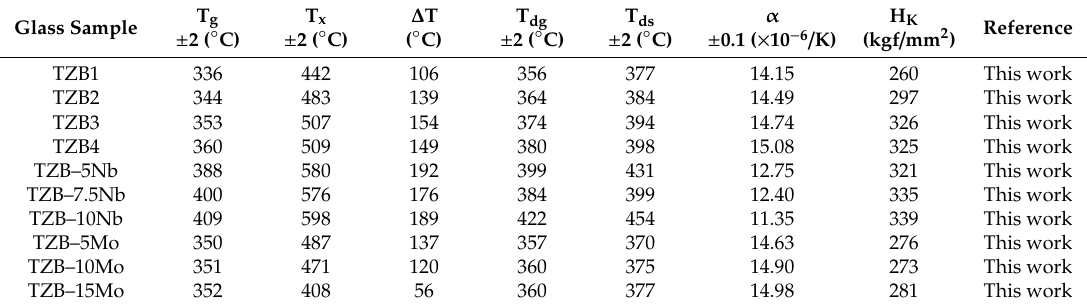
Table 3. The glass transition temperature (T g ), onset crystallization temperature (T x ), glass stability parameter (∆T), dilatometric glass transition temperature (T dg ), dilatometric softening temperature (T ds ), coefficient of thermal expansion (α) and Knoop hardness (H K ) of TeO 2 glasses modified with different contents of BaO, Nb 2 O 5 and MoO 3 at various concentrations.